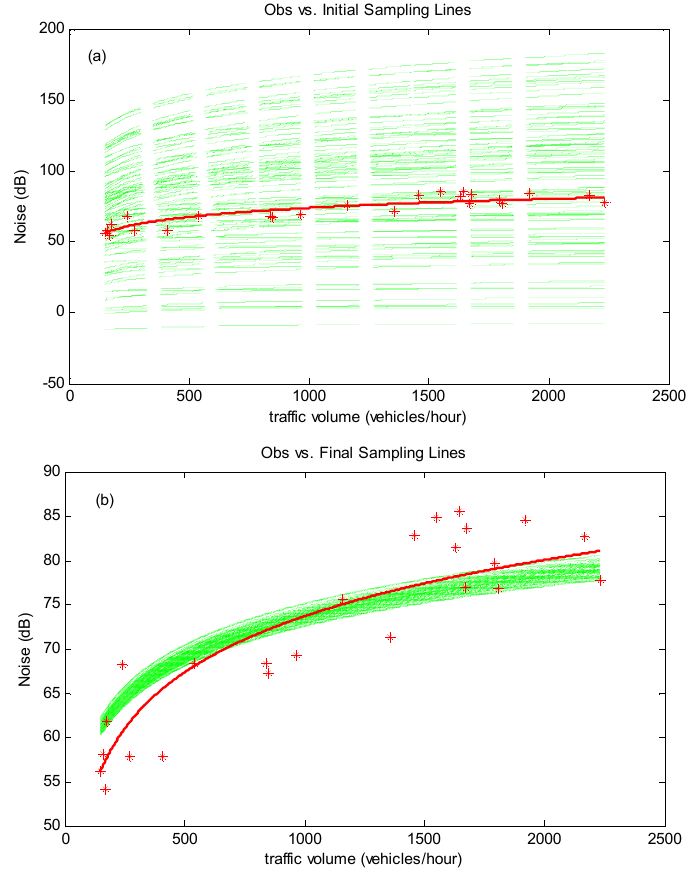
Figure 13. Initial ( a ) and updated ( b ) traffic noise prediction curves in scenario C.